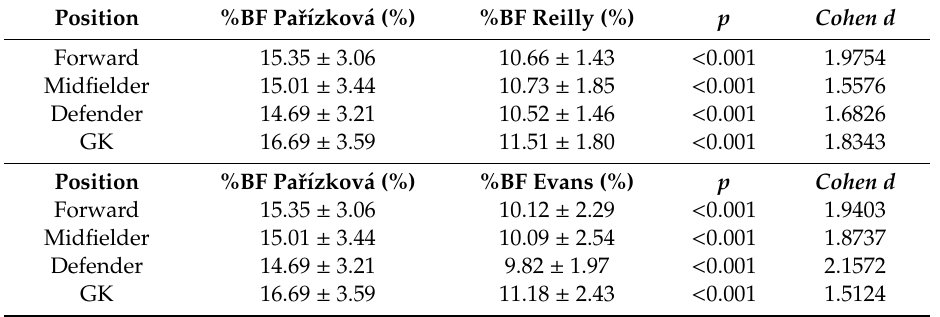
Table 3. %BF estimated using di ff erent equations by playing position for players over 18 years old.